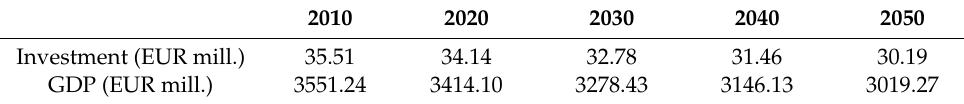
Table 4. Numerical results of investment values and adjusted GDP variation for Scenario 2.